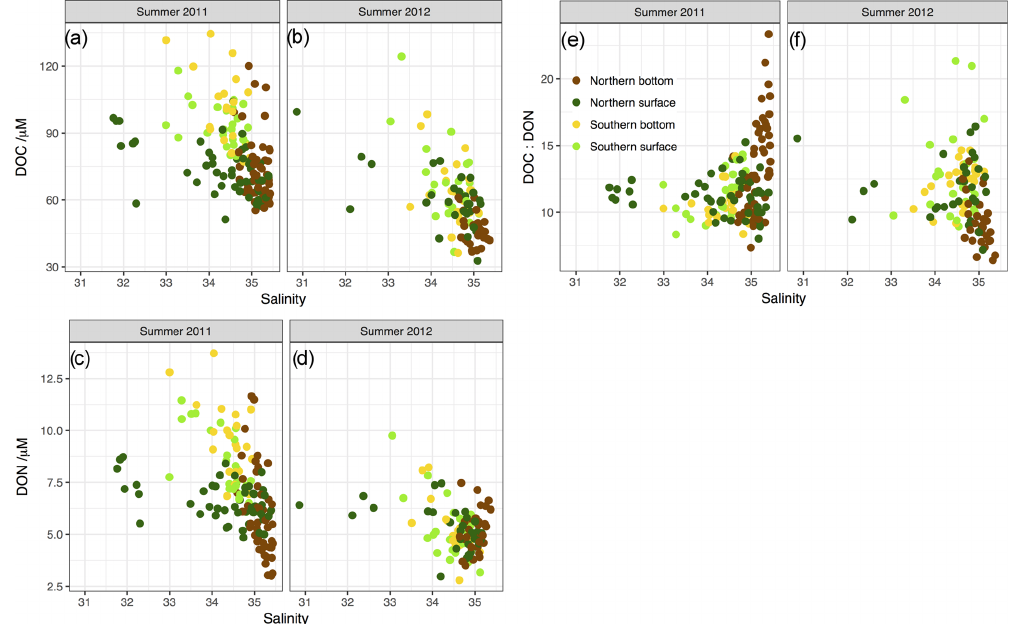
Figure 6. Property–salinity plots for (a) DOC, (c) DON and (e) C : N ratio of DOM for summer 2011. Corresponding plots for summer 2012 are shown in panels (b) , (d) and (f) . Note that regression analysis for property–salinity relationships is presented in Table